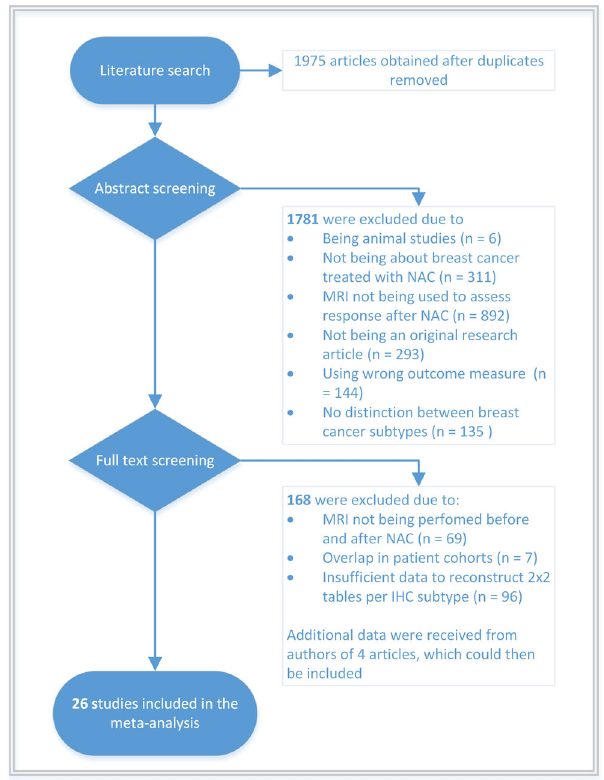
Fig. 1 Flowchart of article selection. 1975 abstracts were screened of which 1781 were excluded. 194 full text articles were screened of which 168 were excluded. Four articles could be included again after initial exclusion because the authors provided additional data. 26 studies could eventually be included in the